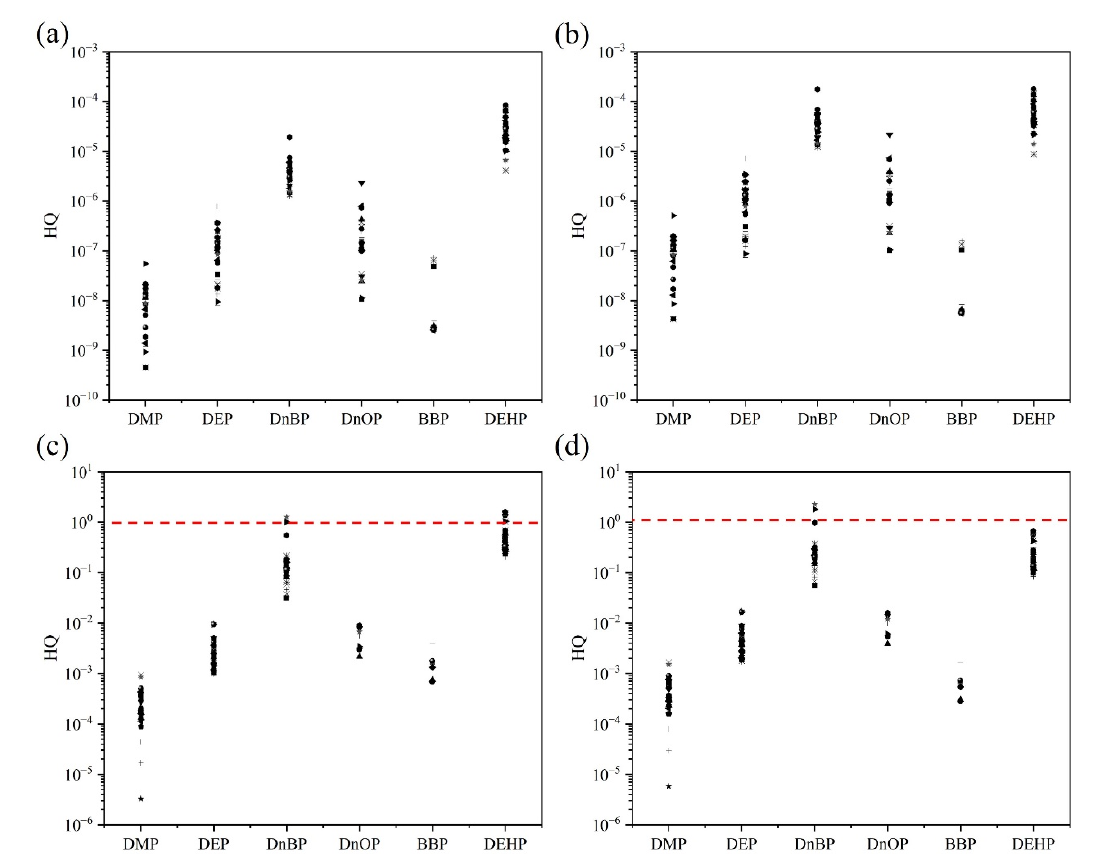
Figure 3. The hazard quotient (HQ) was calculated to assess the noncancer risk from phthalates (PAEs) in soil–plant systems. The dots represent the HQ of the noncarcinogenic risk of PAEs at each sampling site. Adult nondietary noncarcinogenic risk ( a ). Childhood nondietary noncancer risk ( b ). Adult dietary noncarcinogenic risk ( c ). Childhood dietary noncarcinogenic risk ( d ). The auxiliary line with an HQ value of 1.